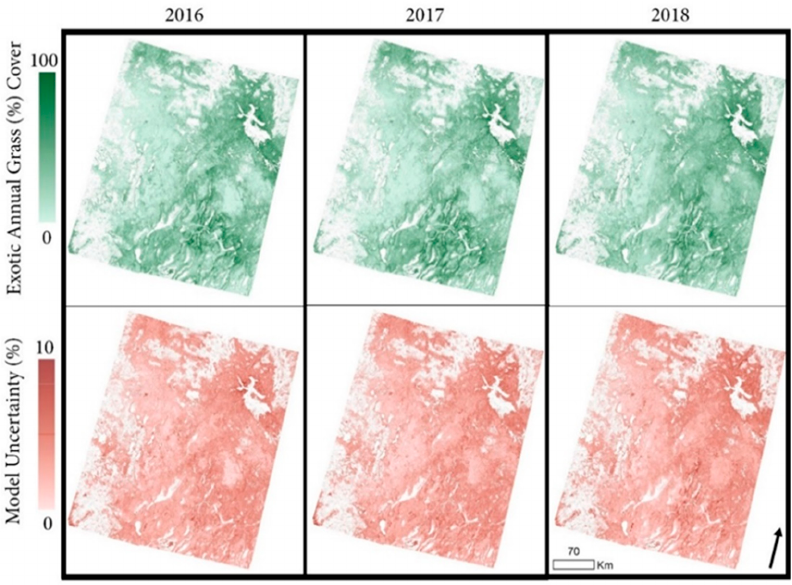
Figure 5. Time series of predicted exotic annual grass cover (%) and associated estimates of uncertainty (standard deviation of 10 model estimates). Areas in white are non-target landcovers as identified from the 2016 National Land Cover Database [45].